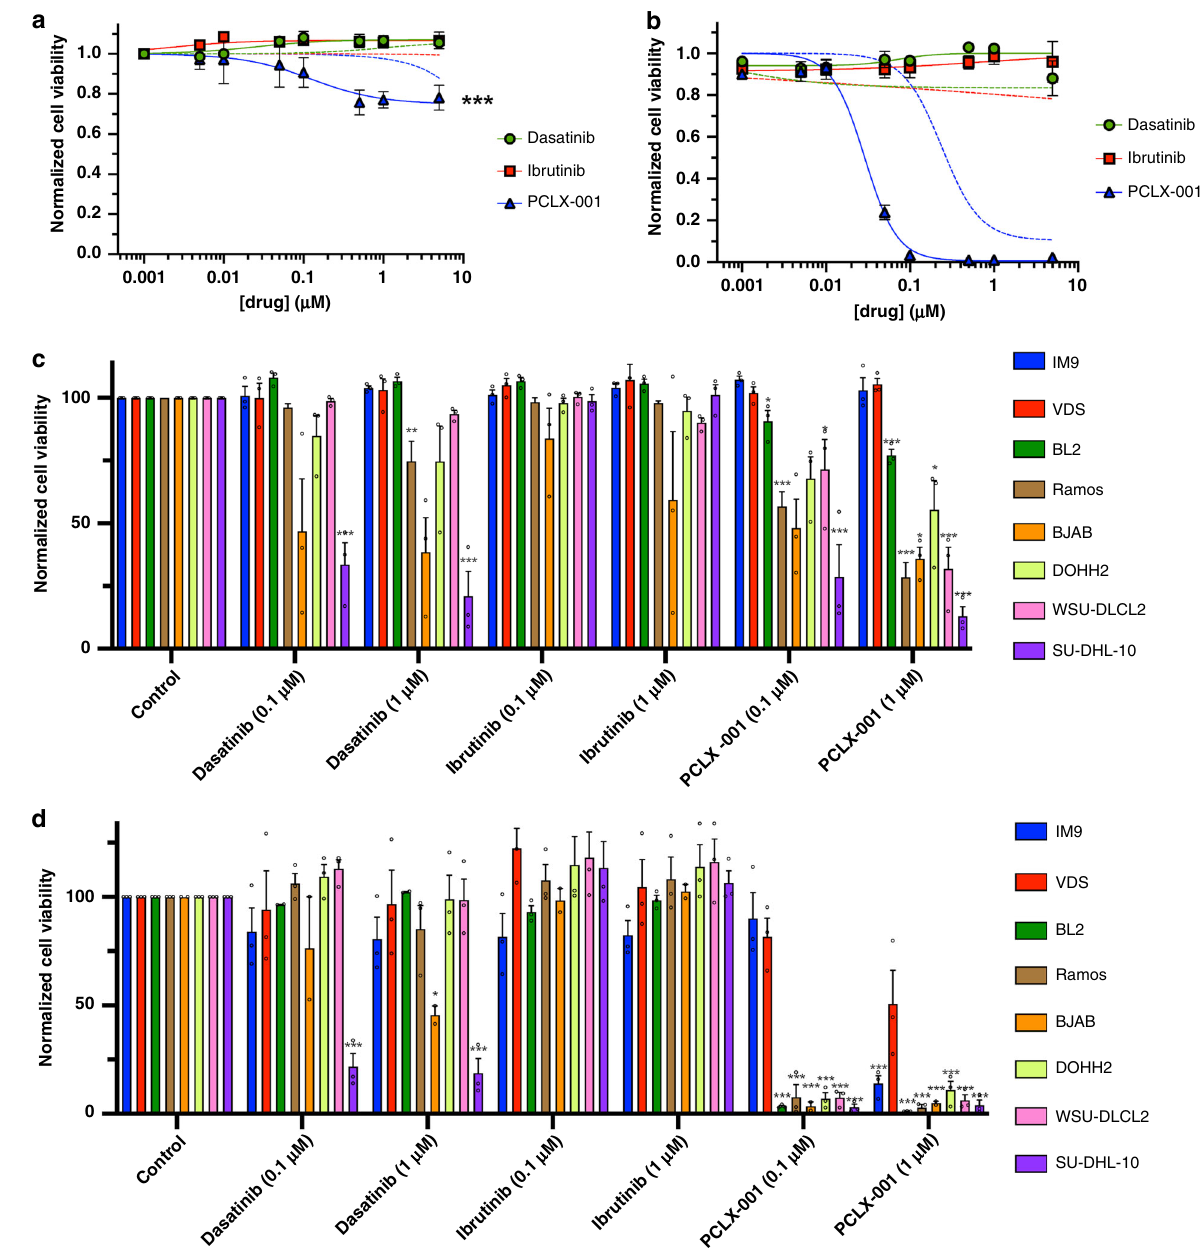
Fig. 6 PCLX-001 selectively kills hematological cancer cells relative to benign lymphocytes in comparison to dasatinib and ibrutinib. Cell viability curves of BL2 (solid lines) and IM9 cells (dotted lines) treated for 48 h ( a ) or 96 h ( b ) with 0.001 – 5 µ M dasatinib, ibrutinib, or PCLX-001(2way Anova, Tukey ’ s multiple comparisons test, P < 0.0001) . Normalized cell viability of immortalized lymphocyte (IM9, VDS), BL (BL2, Ramos, BJAB), and DLBCL (DOHH2, WSU-DLCL2, SU-DHL-10) cell lines treated with 0.1 µ M or 1.0 μ M of dasatinib, ibrutinib or PCLX-001 for 48 h ( c ) and 96 h ( d ). Cell viability for all experiments was measured using Calcein assay and is an average of three independent experiments. (Ordinary one-way Anova, Dunnett ’ s